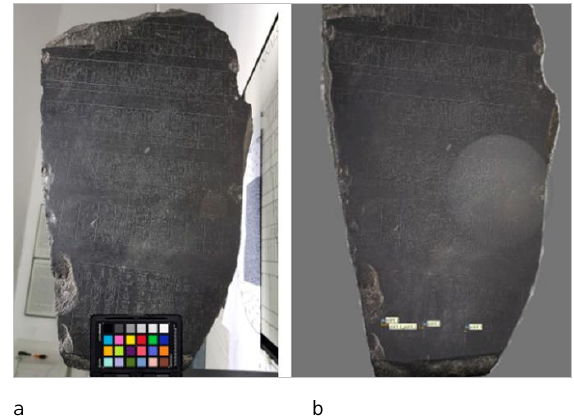
Figure 5: 5.a X-Rite ColorChecker Passport (CC) target close the stone; 5.b markers points on the S8+ model. The S8+ camera specs have been used during the camera calibration process. Tab. 2.